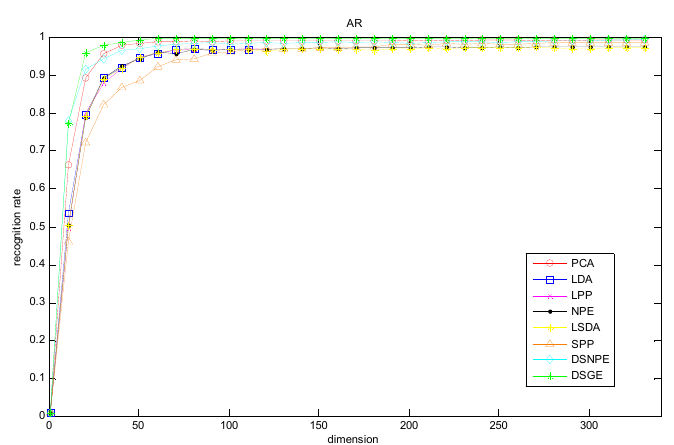
Figure 4. Recognition rate vs. variation of dimension on the AR database.